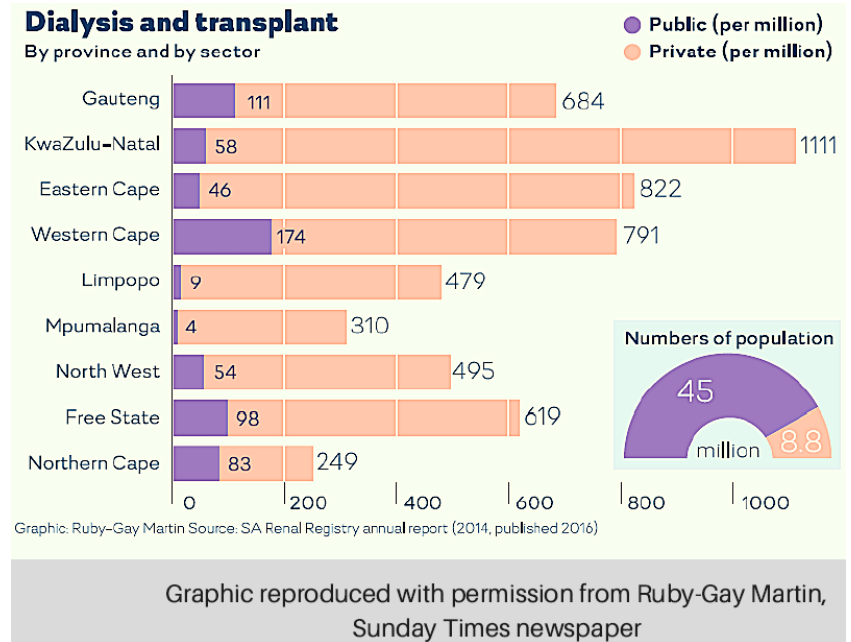
Figure 2. National treatment rates for ESRD in state and private sectors.